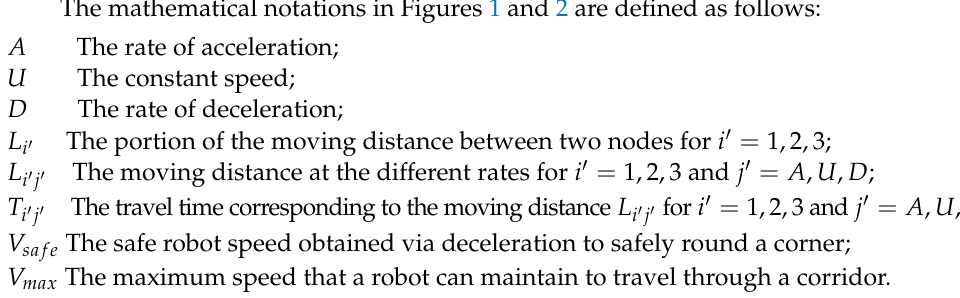
Figure 2. Graph of moving speed and travel time of robot.